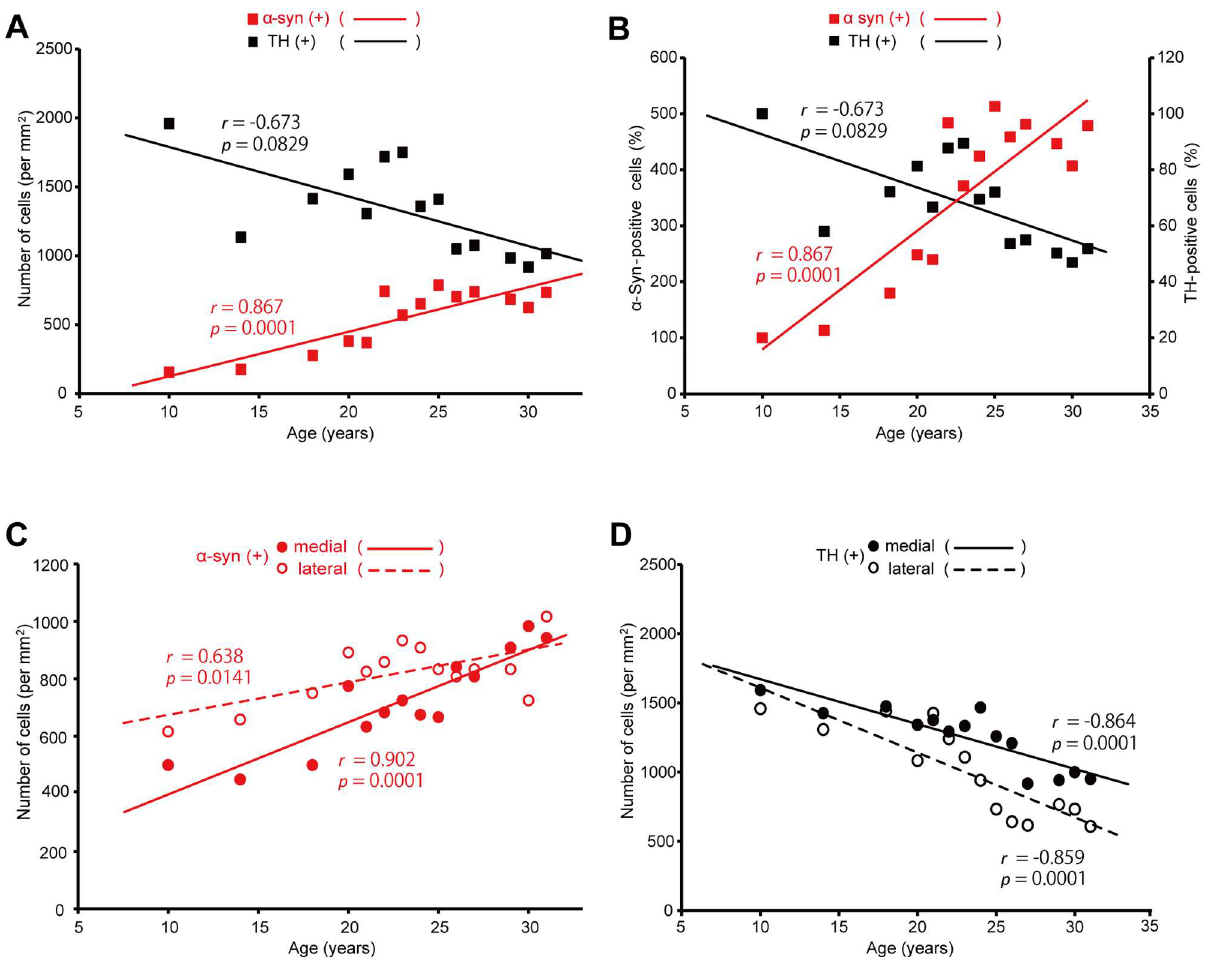
Fig 1. Age-dependent distribution changes in α -syn-positive and TH-positive neurons in the SNc. A: Number of α -syn-positive or TH-positive neuronsin the area of 1 mm 2 . The red or black line with filled squaresrepresents the α -syn-positive or TH-positive neuron number, respectively. B: Ratio of the α -syn-positive (specifiedby the red line with filled squares)or TH-positive (specifiedby the black line with filled squares)neuronnumber to each number at 10 years of age. C: Number of α -syn-positive neuronsin the medialor lateral part of the SNc. The neuronnumberis indicatedas that in the area of 1 mm 2 . The solid line with filled circles or broken line with open circles represents the neuronnumber in the medialor lateral part, respectively. D: Number of TH-positive neuronsin the medial (denoted by the solid line with filled circles) or lateral (denotedby the broken line with open circles) part of the SNc. The neuronnumber is indicatedas that in the area of 1 mm 2 . See the text for methodological